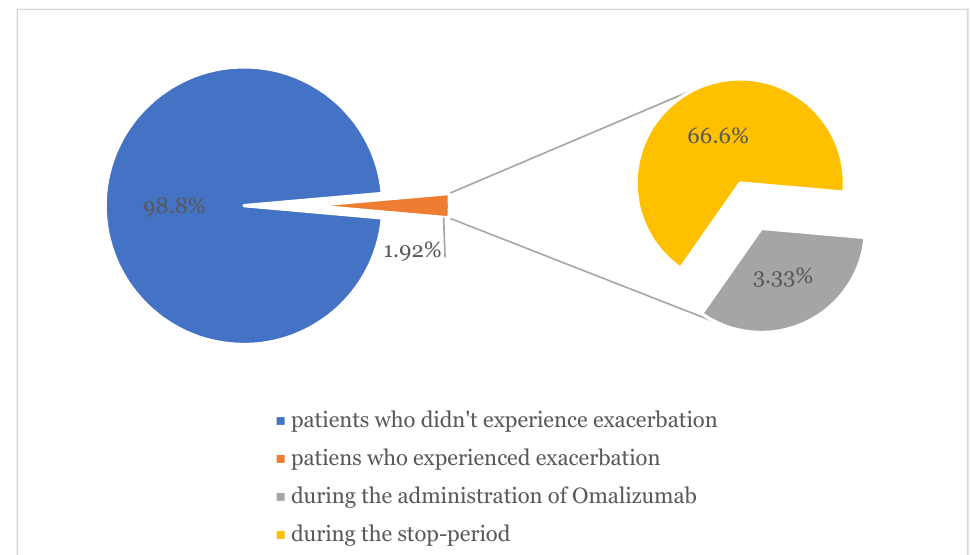
Figure 1. Adverse Events Following Immunization (AEFI) and exacerbation of CSU/CIU symptoms observed in patients taking antihistamines and omalizumab therapy, respectively.